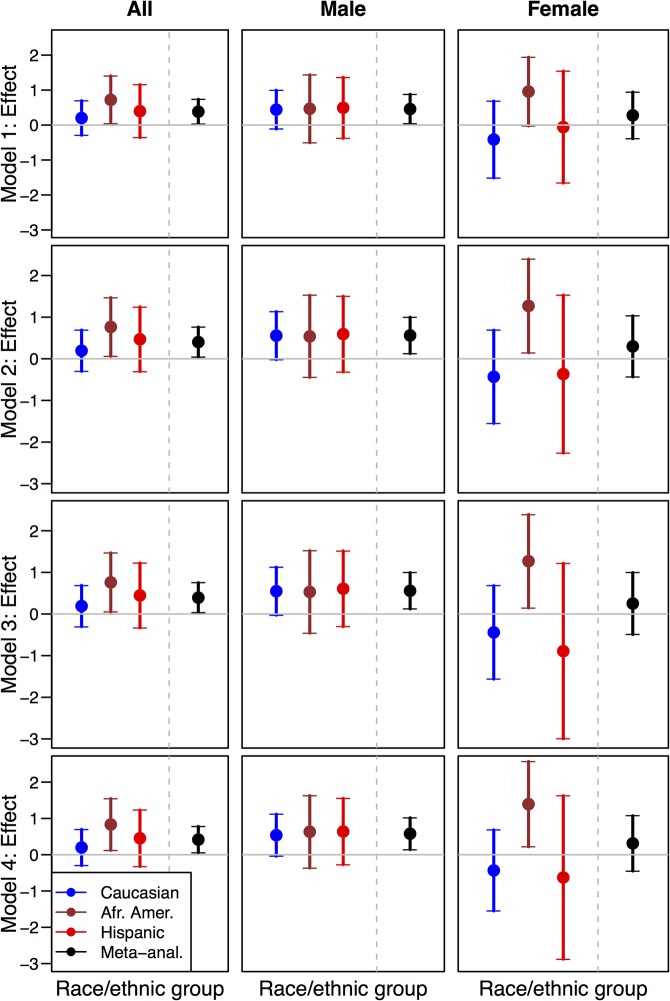
Effect estimates (log hazard ratio of CHD for rs4238001 effect allele T) and corresponding 95% confidence intervals shown for Model 1 (basic), Model 2 (extended), Model 3 (Model 2 + lipid medication) and Model 4 (NMR lipids).Analyses were conducted stratified by race/ethnic group and combined by meta- analysis, for all participants as well as stratified by sex (males or female).